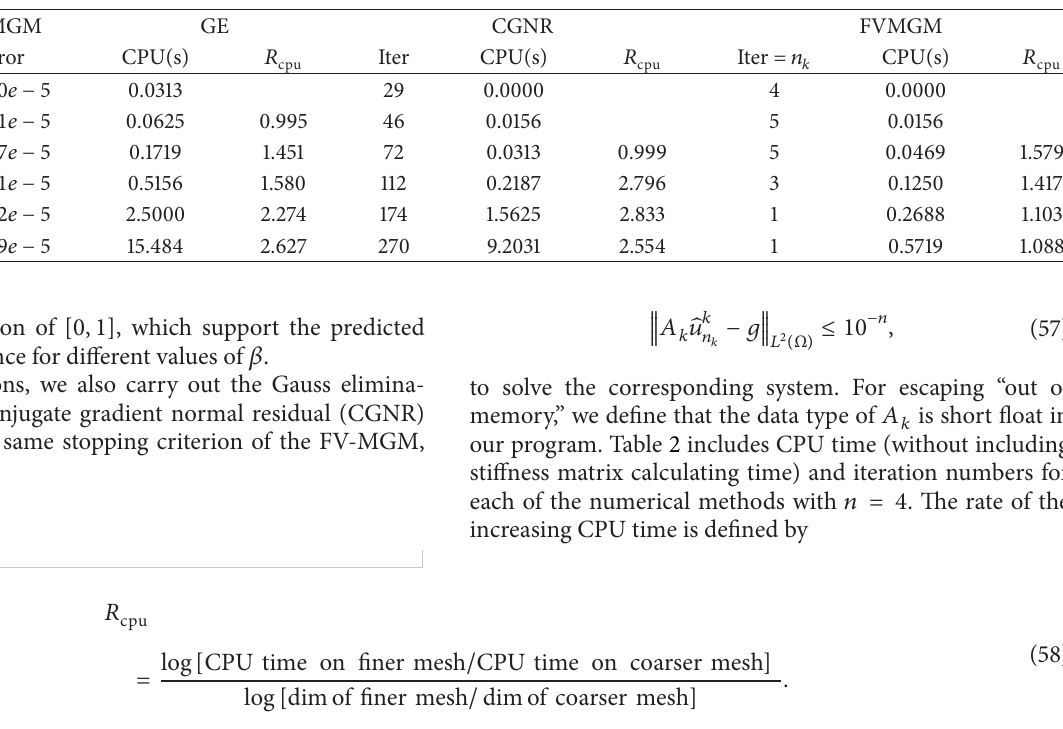
Table 2: Comparisons for solving Example 30 with 𝛽 = 0.7 by the GE method, the CGNR method, and the FV-MGM,